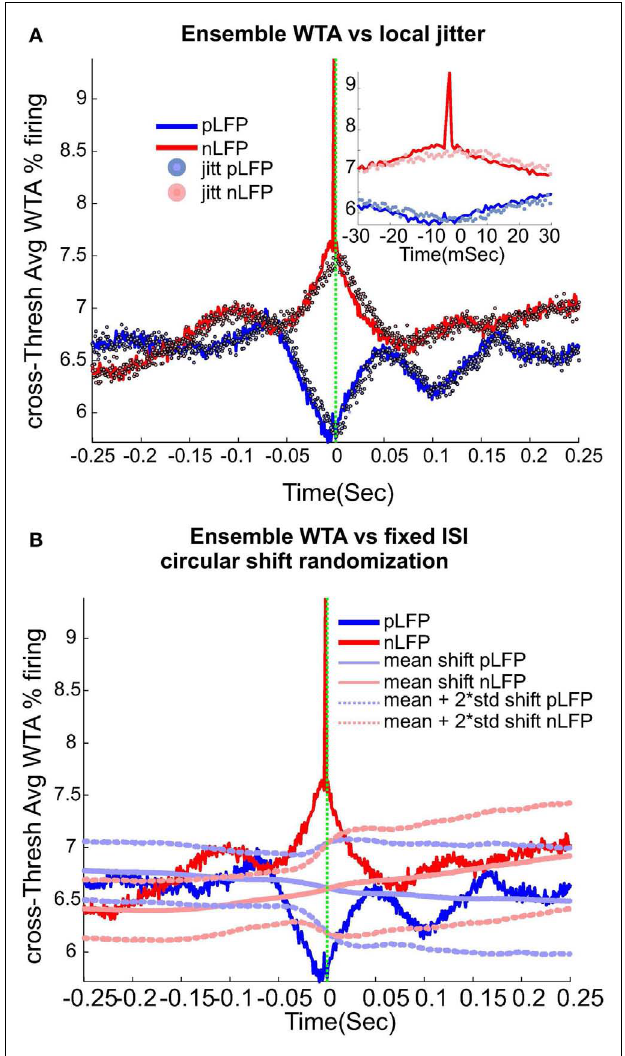
FIGURE 6 | Relation between unit firing and LFP peaks in wakefulness. nLFP (red) and pLFP(blue)-based wave-triggered-average (WTA) of percentage unit activity, showing that the negative peaks have closer association with an increase of neuronal firing. (A) Tightly regulated local jitter of nLFP peaks destroys the large nLFP peak. Inset shows the zoom around 0. (B) Preserving the internal structure of aggregate spike train and ensemble LFP peaks, but destroying the relation between the two leads to the disappearance of the nLFP peak. See text for details of randomization and controls.TheWTA traces in this figure are from Human i, (based on 183127, 98520, and 47451 nLFP and 158737, 79225, and 36020 pLFP peaks for low, medium, and high threshold